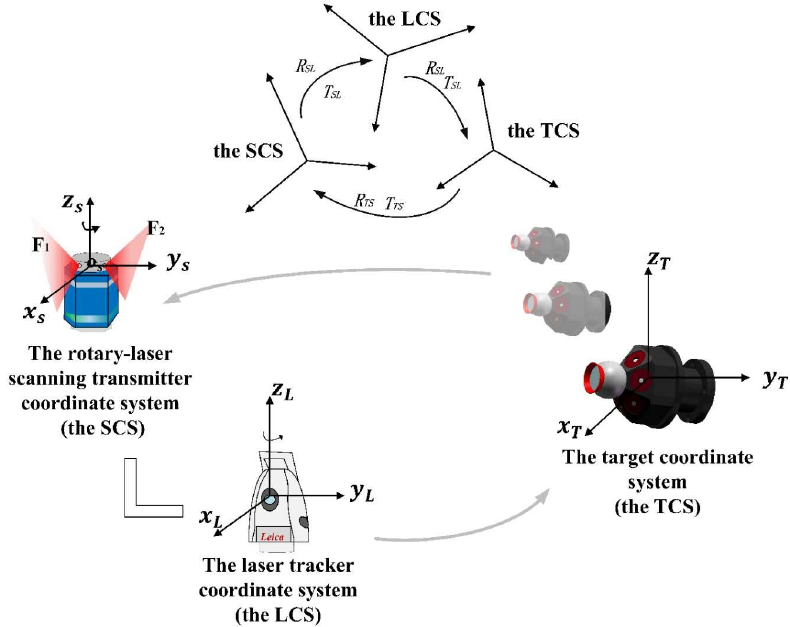
Figure 3. Measurement principle of single-station rotary-laser transmitter: ( a ) six receivers and a of single station measurement and applied to guidance experiment in this paper.